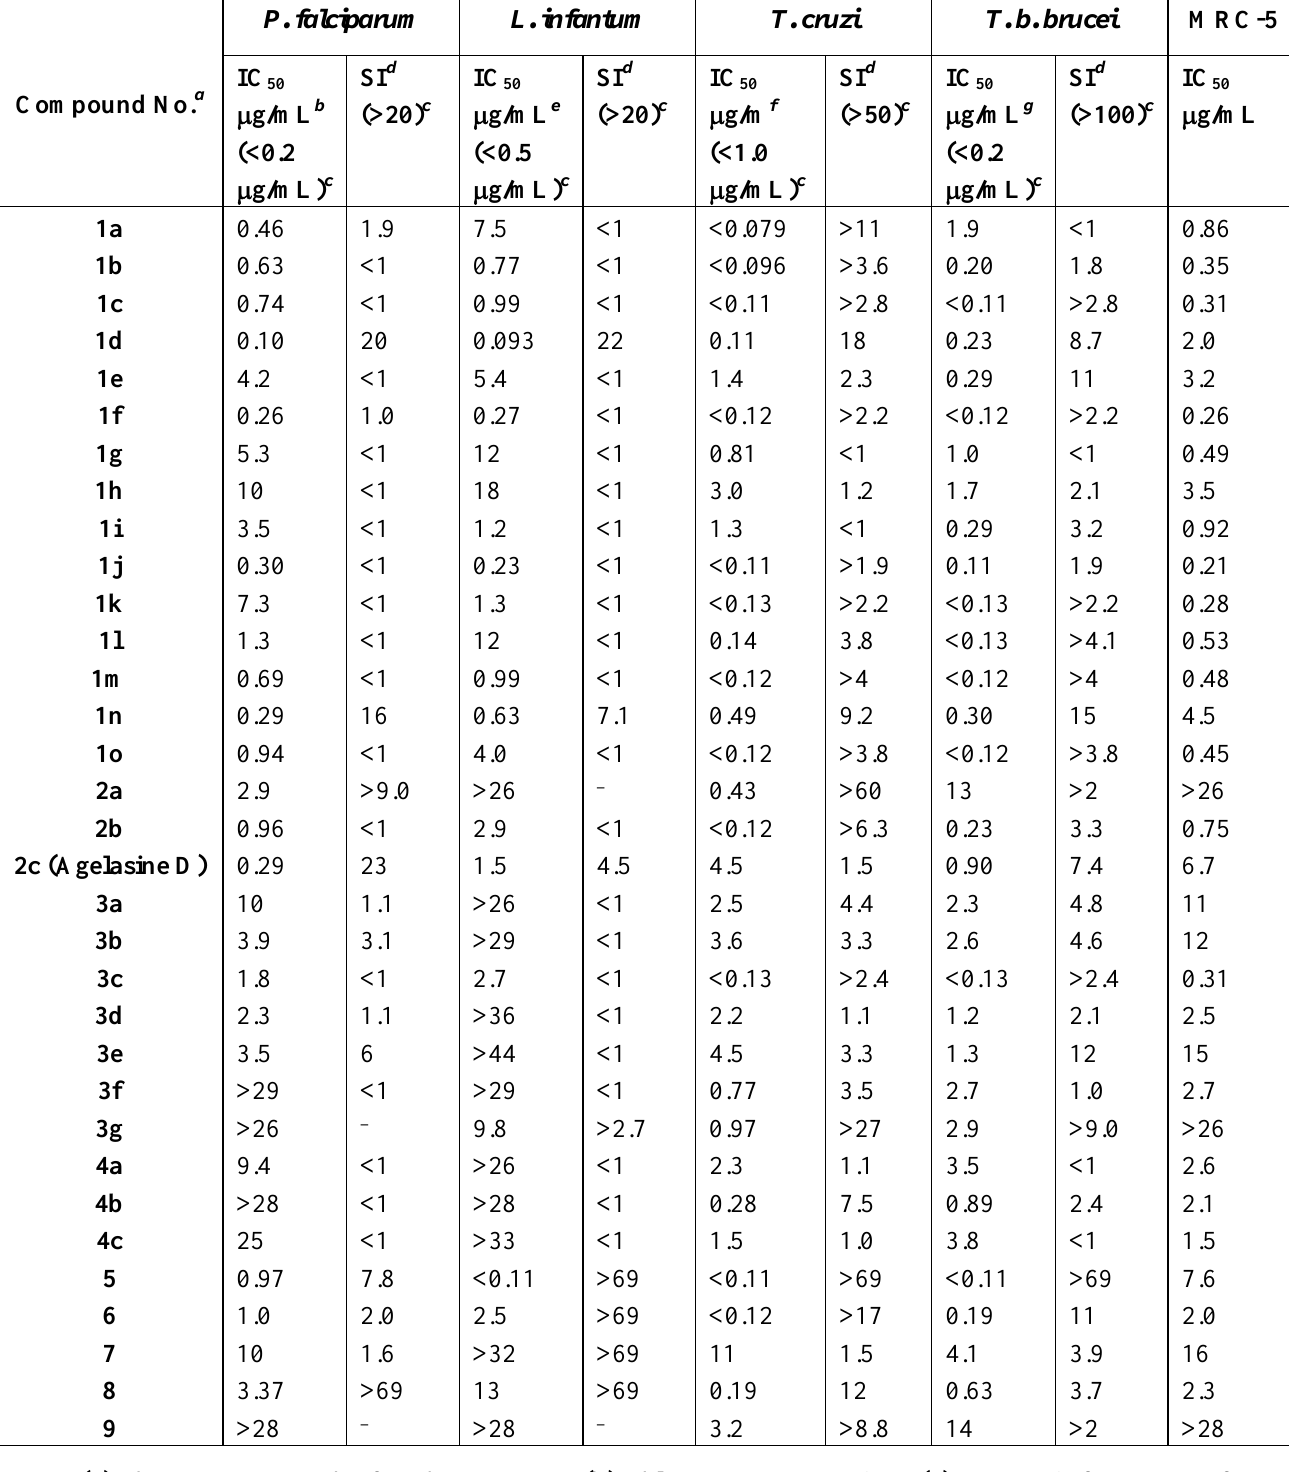
Table 1. Activity of compounds 1 – 9 against P. falciparum, L. infantum, T. cruzi and T. b. brucei , as well as MRC-5 fibroblast cells.